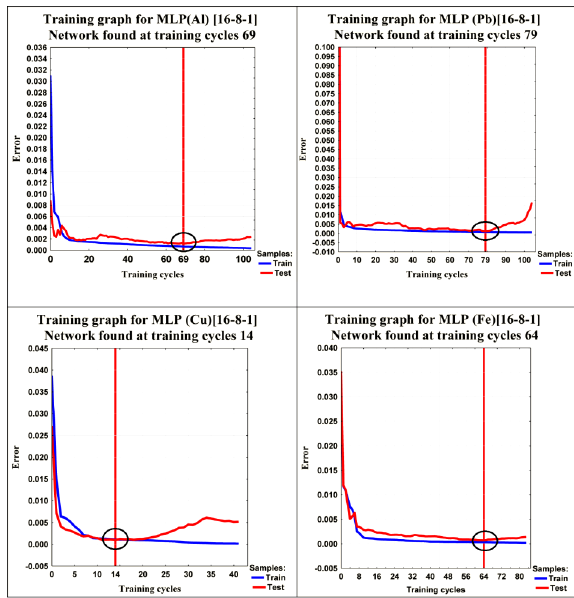
Figure 8. Evolution of the quadratic sum of the errors (function of the cost) with eight neurons in the hidden layer for the four heavy